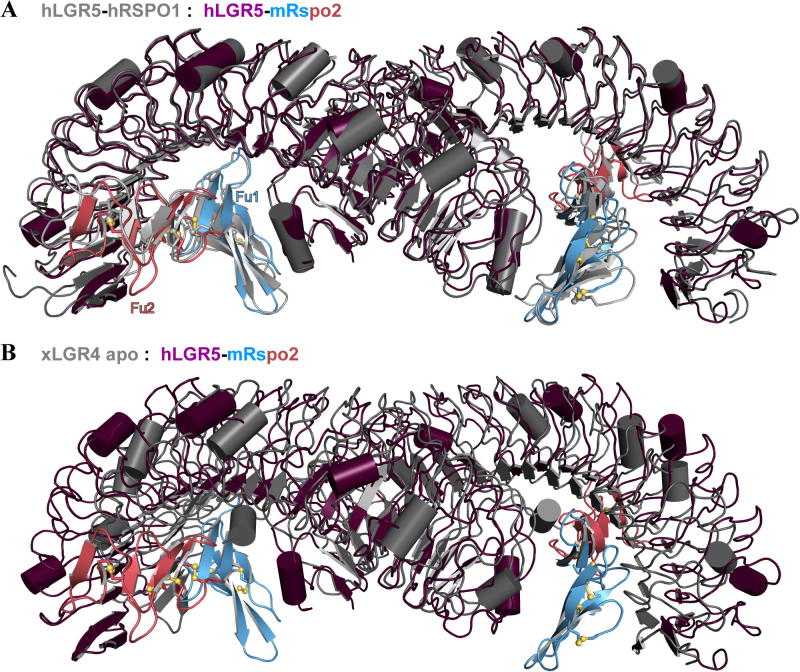
A recurring dimeric arrangement of LGR receptor ectodomains. Superposition of hLGR5ecto–mRspo2Fu1-Fu2 (coloured) with the hLGR5ecto–hRSPO1Fu1-Fu2 complex (gray, PDB entry 4BSR) in A and with the xLGR4ecto apo structure (gray, PDB entry 4LI1) in B.